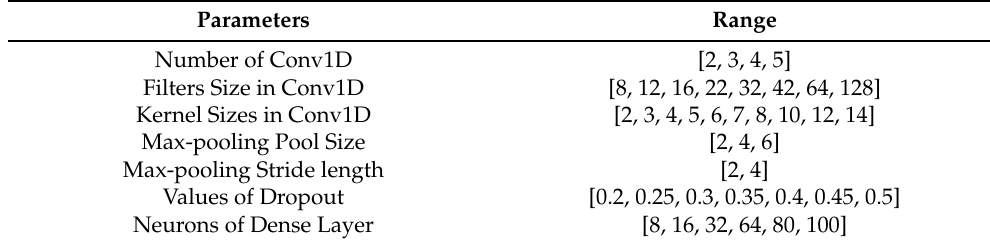
Table 2. Ranges of Parameters in Hyperparameter